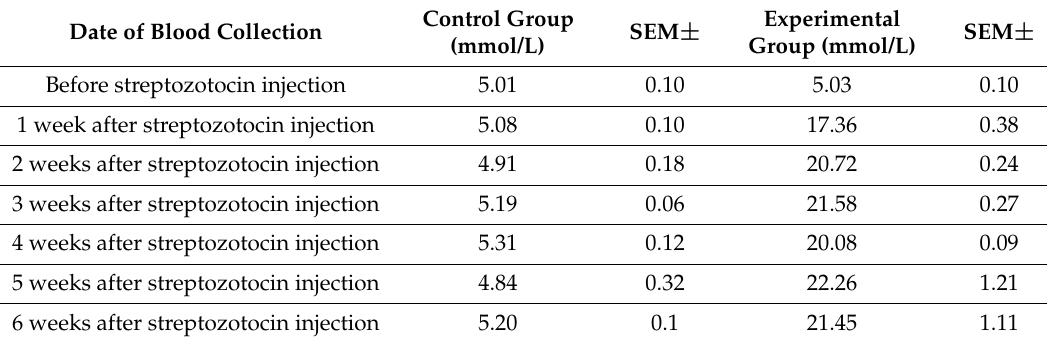
Table 1. Serum glucose levels after induction of diabetes and glucose concentration after streptozotocin administration (up to six